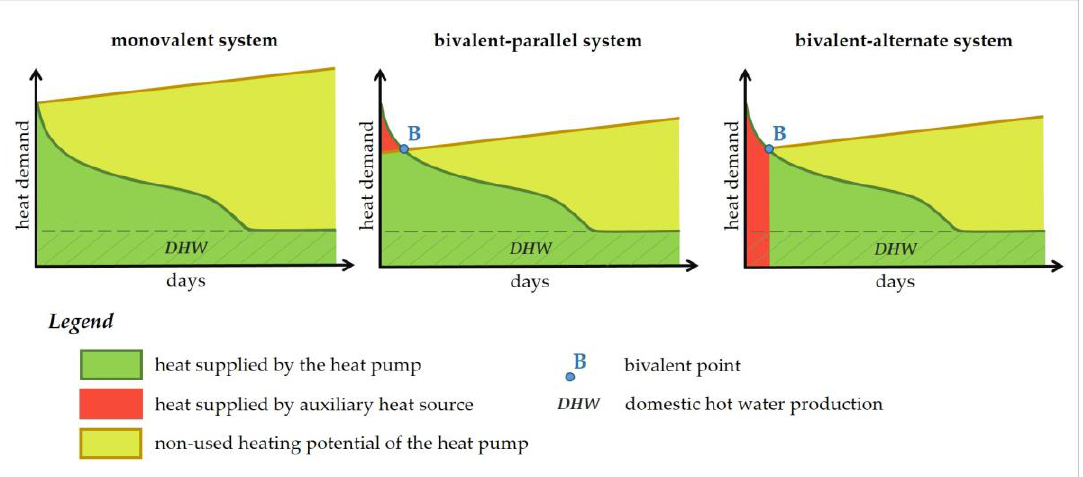
Figure 2. Schematic figures of heat supply in different modes of heat pump systems based on the heat demand duration curve and the bivalent point.